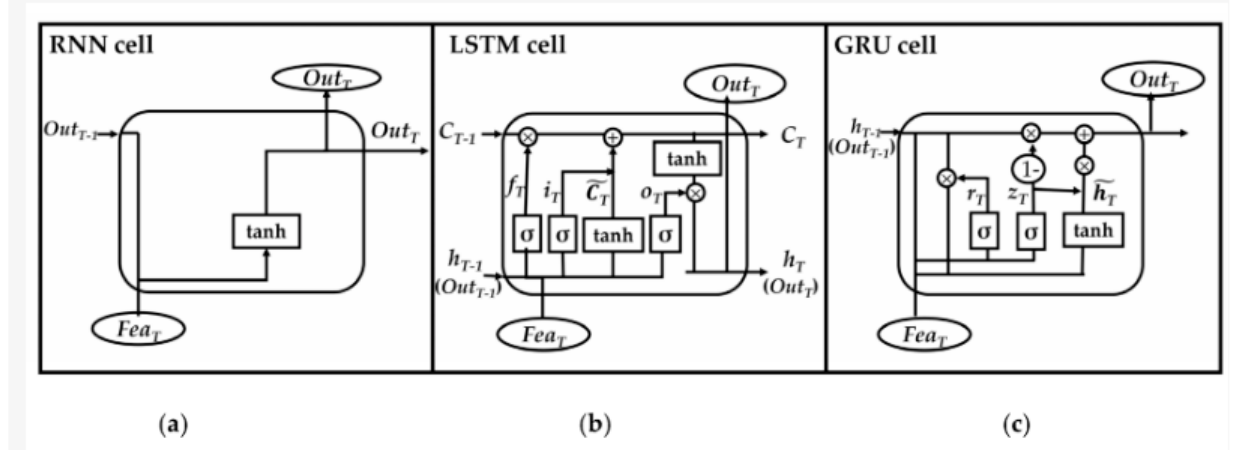
Figure 1. Types of recurrent neural network ( a ) RNN ( b ) LSTM ( c ) GRU models. This gate decides which input passes through the network and which input is thrown